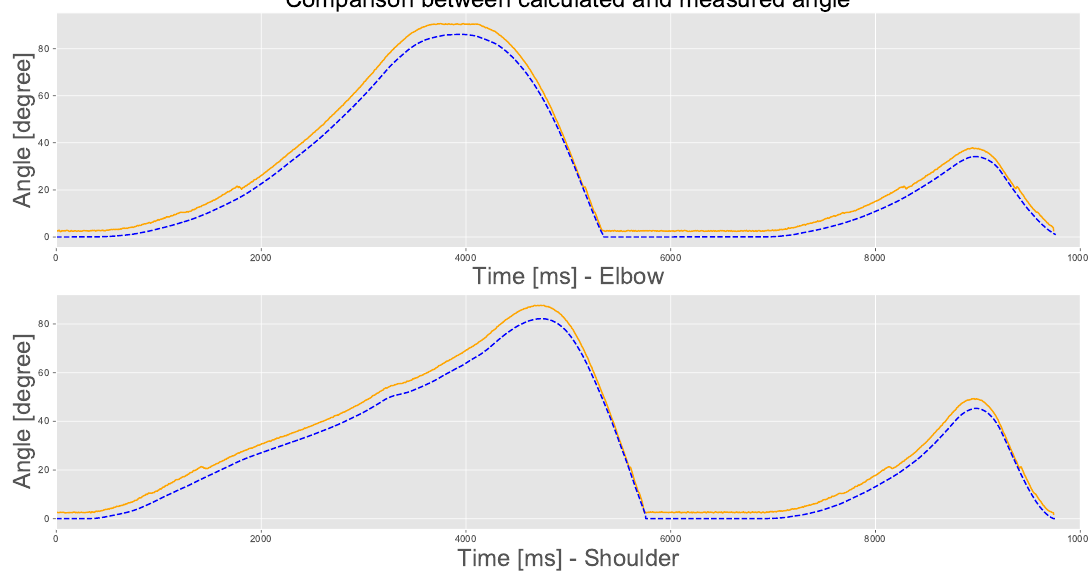
Figure 12. Graph of the trajectory of the elbow and shoulder joint test. The solid blue line is the values read by the gyroscope, and the dashed orange line is the value computed by the control.